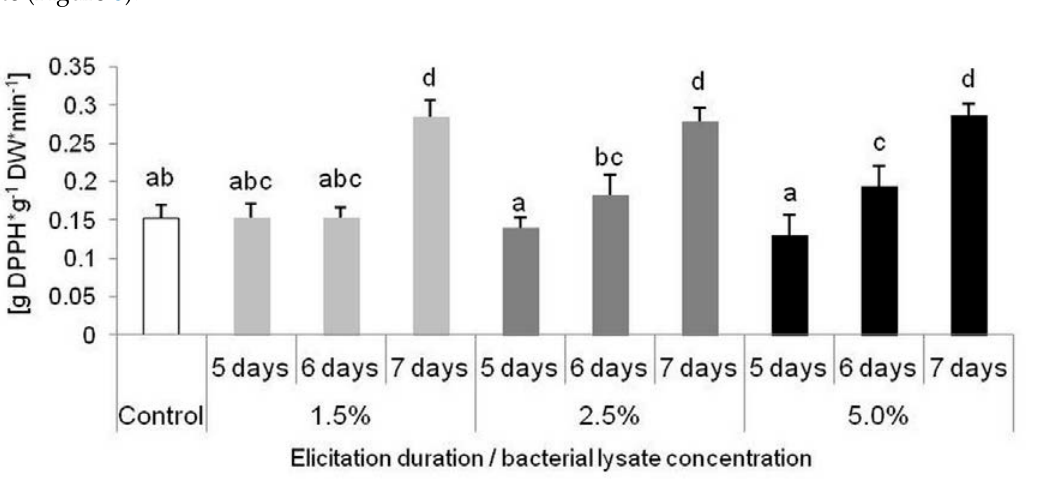
Table 1. Minimal bactericidal concentration (MBC) of S. aureus and E. coli after treatment with extracts of Dionaea muscipula plants after five, six and seven days of elicitation with Cronobacter sakazaki lysate in different concentrations. Concentration of C. sakazaki lysate (%)